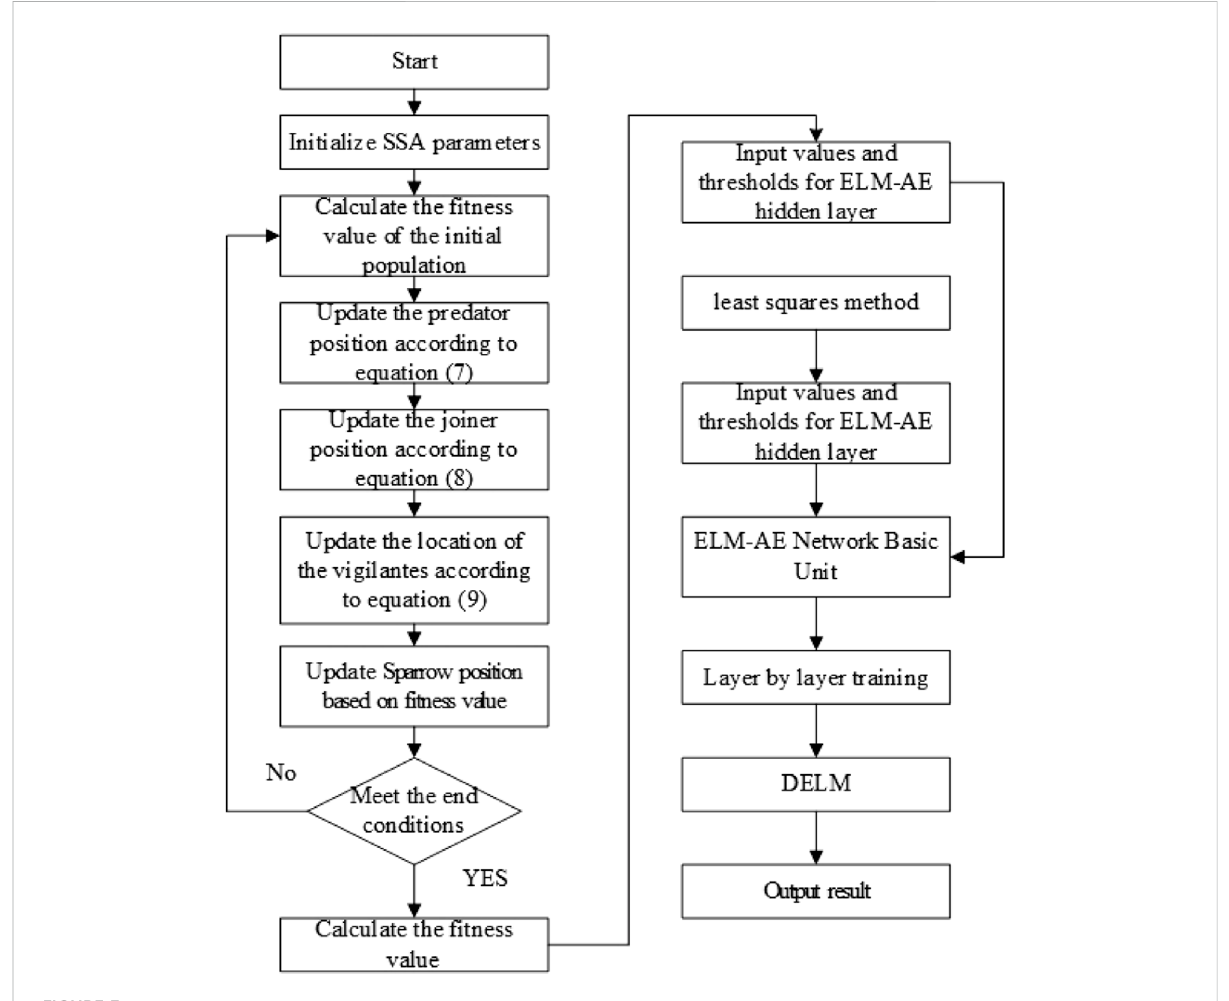
FIGURE 3 SSA-DELM fl ow